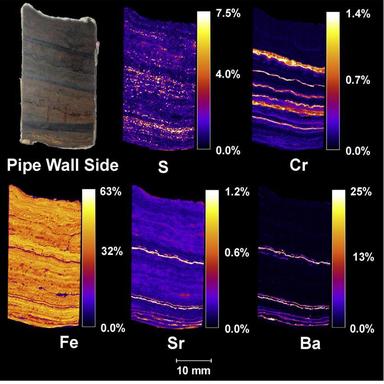
Micro-XRF mapping of sample 1.